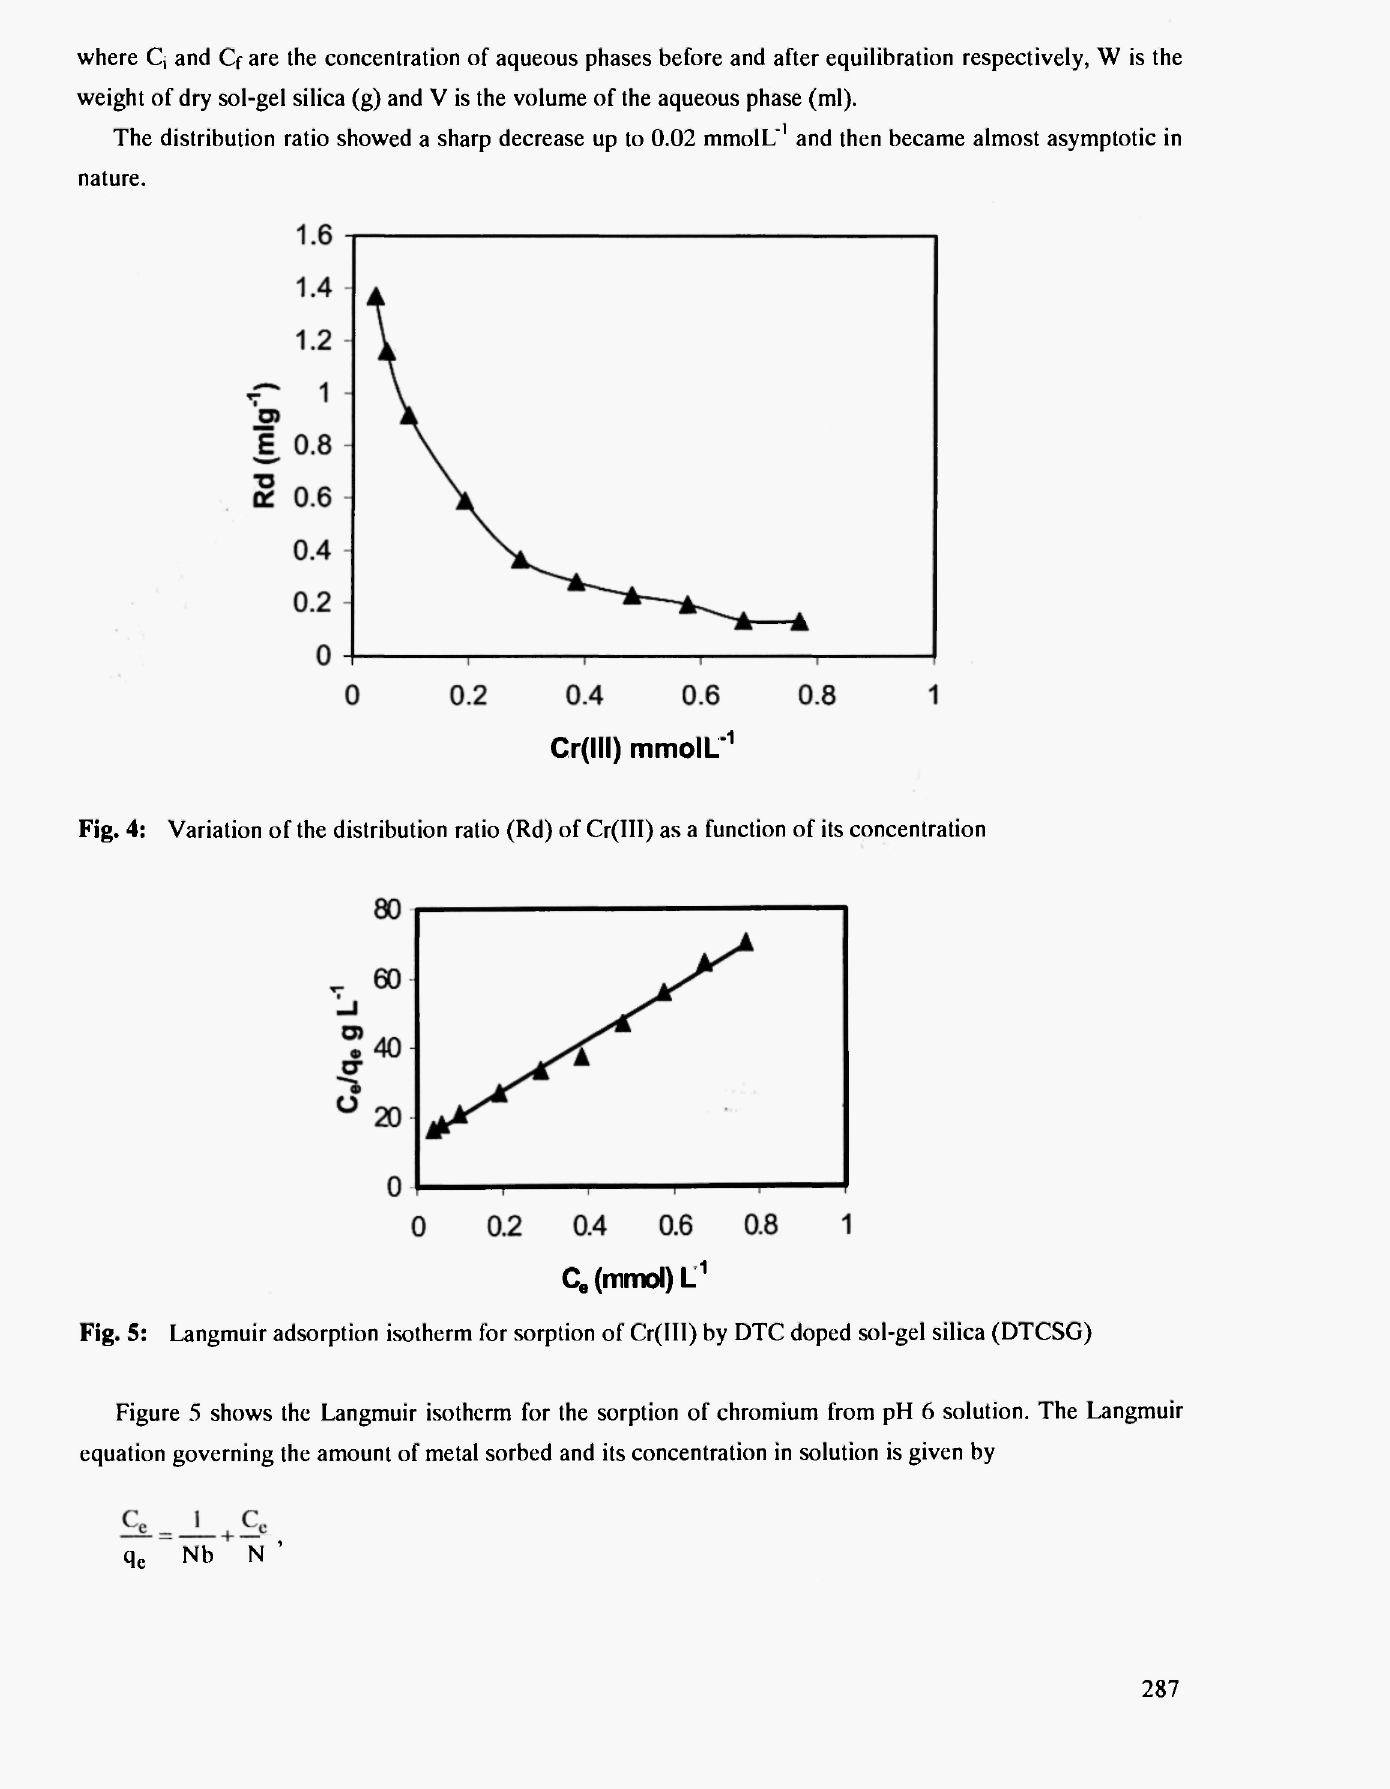
Fig. 4: Variation of the distribution ratio (Rd) of Cr (III) as a function of its concentration